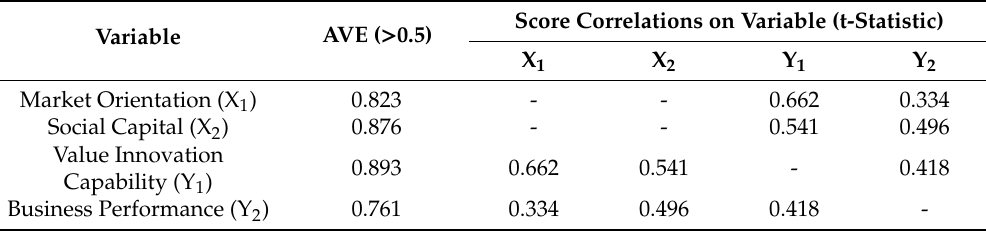
Table 2. Average variant extracted (AVE) Correlation and Score.